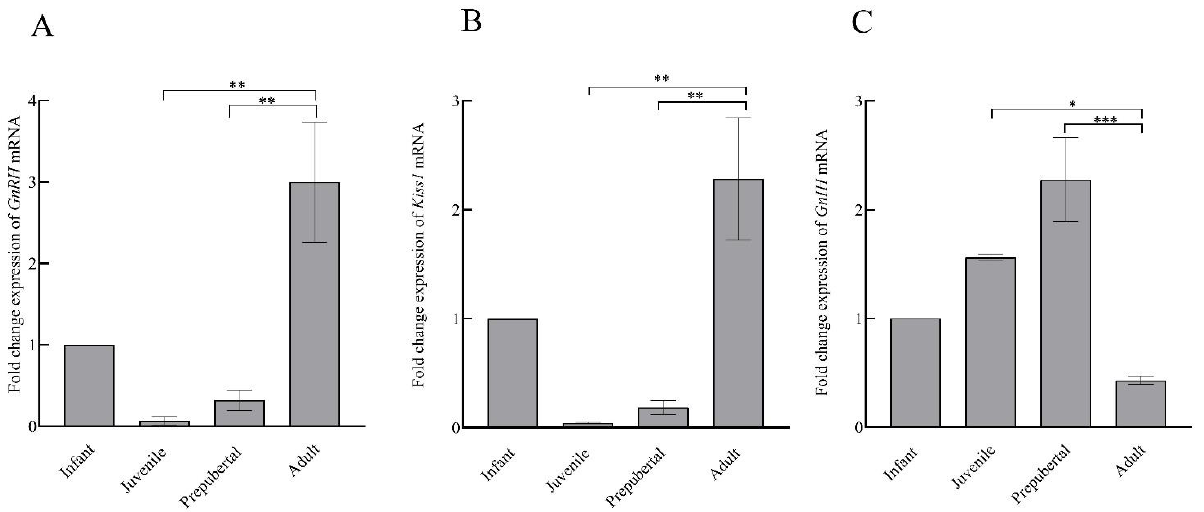
Figure 6. The mean ± SEM hypothalamic fold change expression of GnRH ( A ), Kiss1 ( B ), and GnIH ( C ) mRNA during pubertal development in male rhesus monkeys. * p < 0.05, ** p < 0.01, *** p < 0.001.